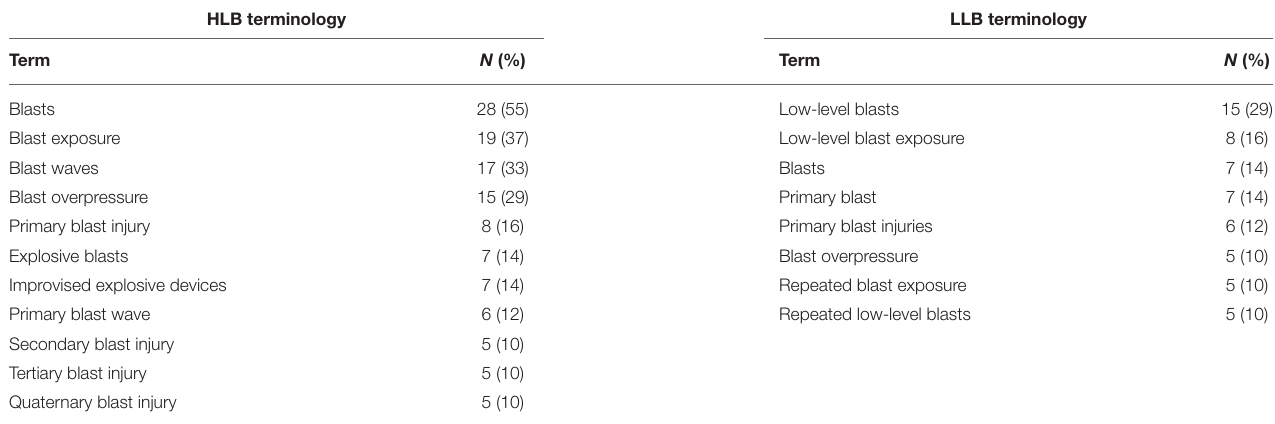
TABLE 1 | Commonly used terms to describe high-level blast (HLB) and low-level blast (LLB),